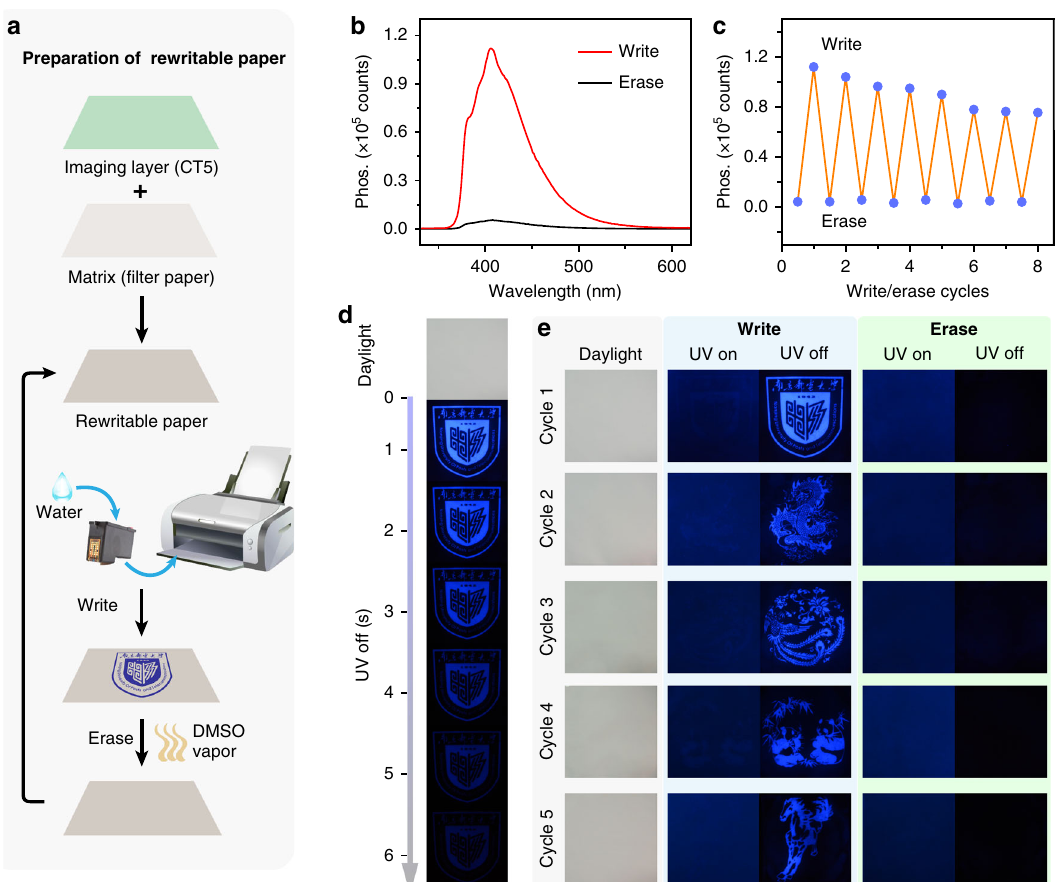
Fig. 5 Water-jet rewritable encryption papers. a Preparation of the rewritable encryption paper using pure water as ink. b Phosphorescence spectra of rewritable paper after writing and erasing. c Reversibility of the rewritable paper. d Photographs of the pattern under daylight and after the removal of 254 nm UV light. e Photographs taken during fi ve cycles of the write/erase processes under daylight, UV light (UV-on), and after removal of the excitation